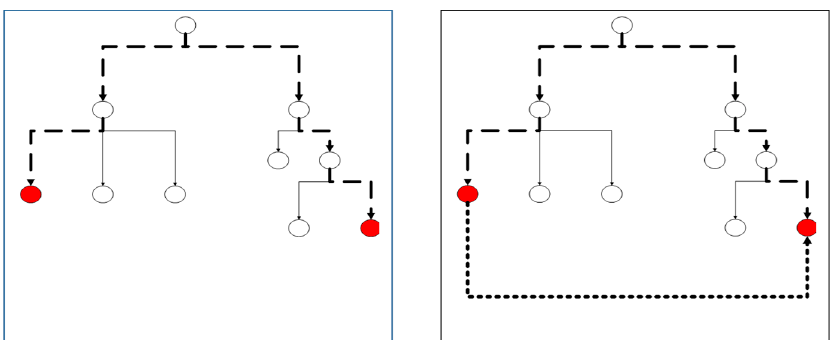
Figure 9. From the hierarchy of responsibilities to the knowledge network.